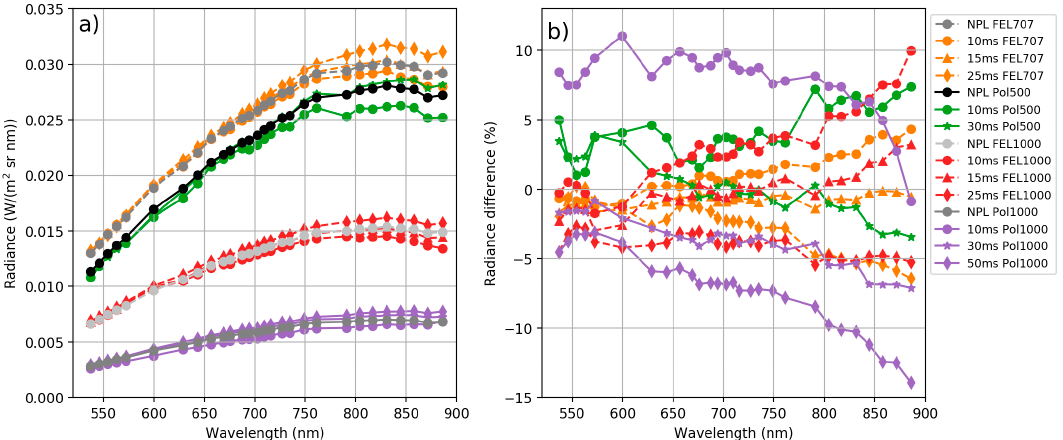
Figure 11. Band wise linear model parameters ( a ) a and ( b ) b to adjust L man radiance using Equation (6). Parameters solved using 11 data sets. Light blue colour indicates 95% confidence interval for parameters from least squares calculations.